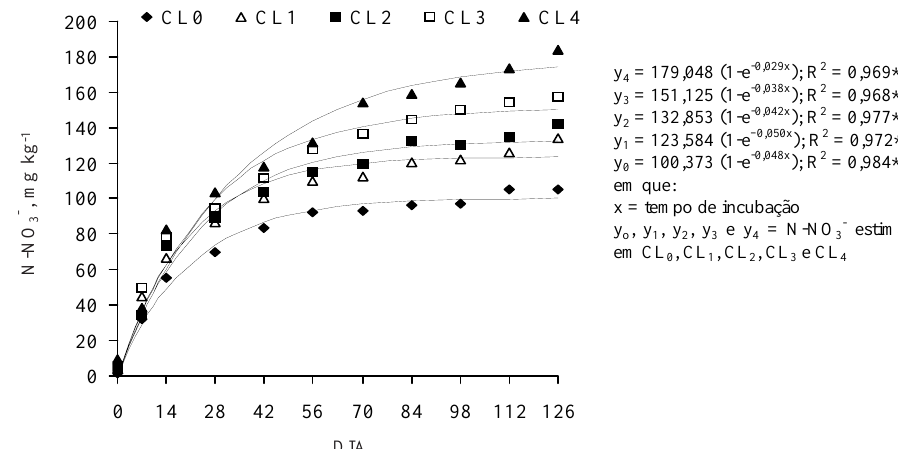
Figura 5. Teores de N-NO 3- no solo, considerando o tempo de incubação, no tratamento não adubado (CL ) e nos adubados com 30 (CL 0